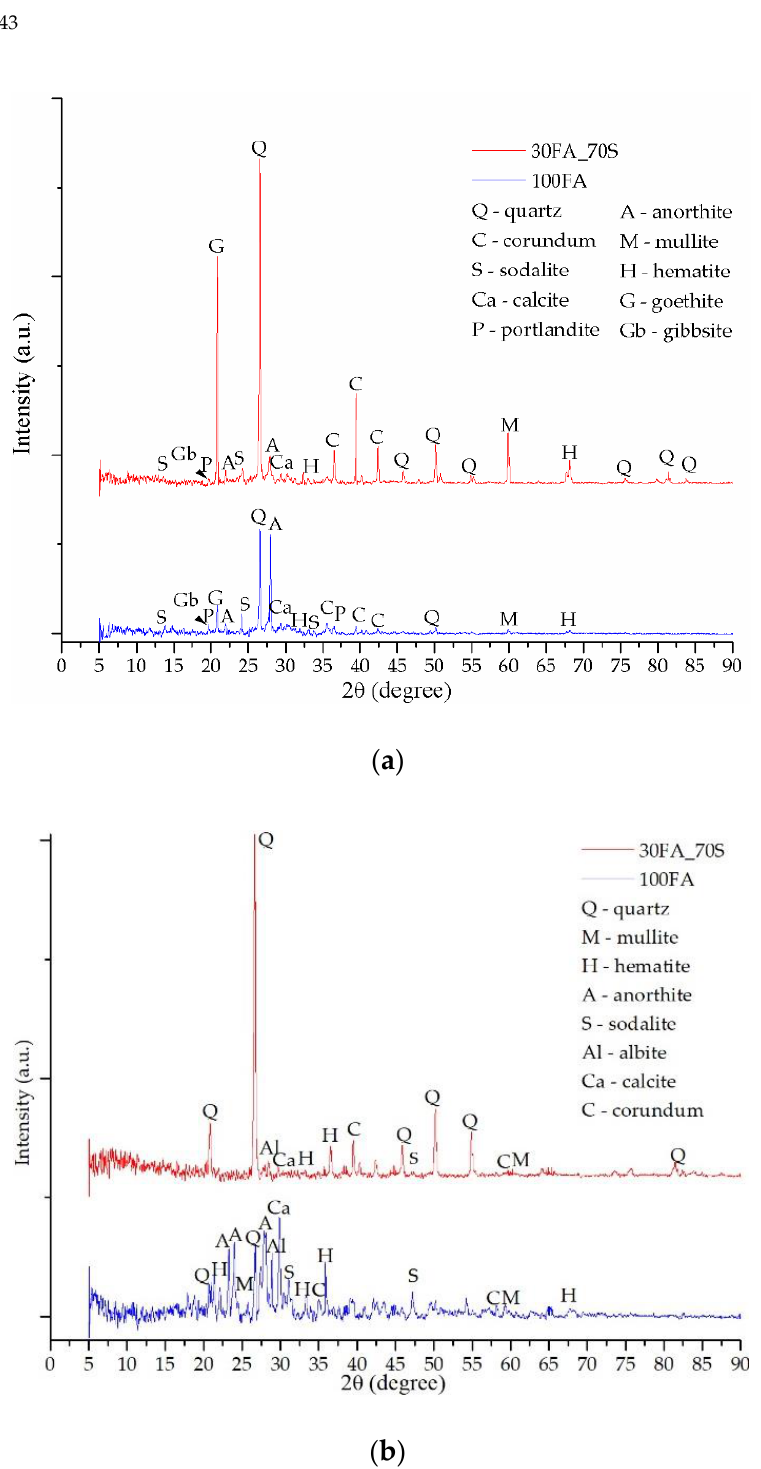
Figure 9. XRD patterns of sample 100FA and sample 30FA_70S: ( a ) prior TG-DTA analysis; ( b ) after TG-DTA analysis.